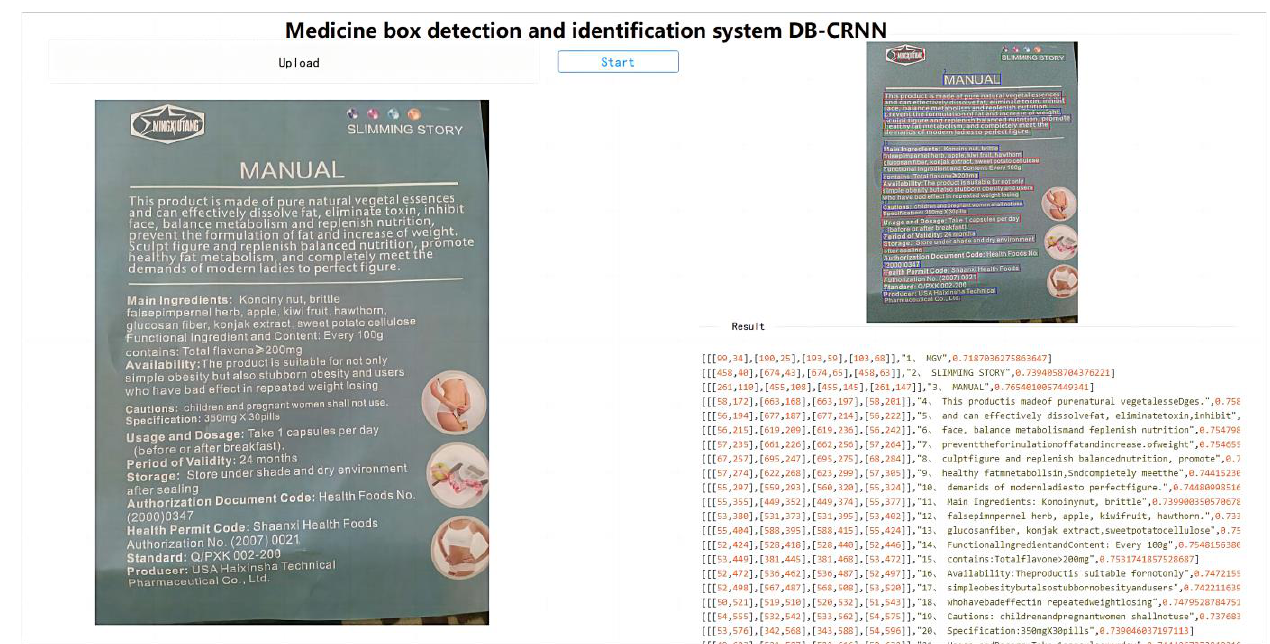
Figure 14. Drug instruction identification process and identification results. Table 2. Results of drug instruction identification using traditional and proposed methods.